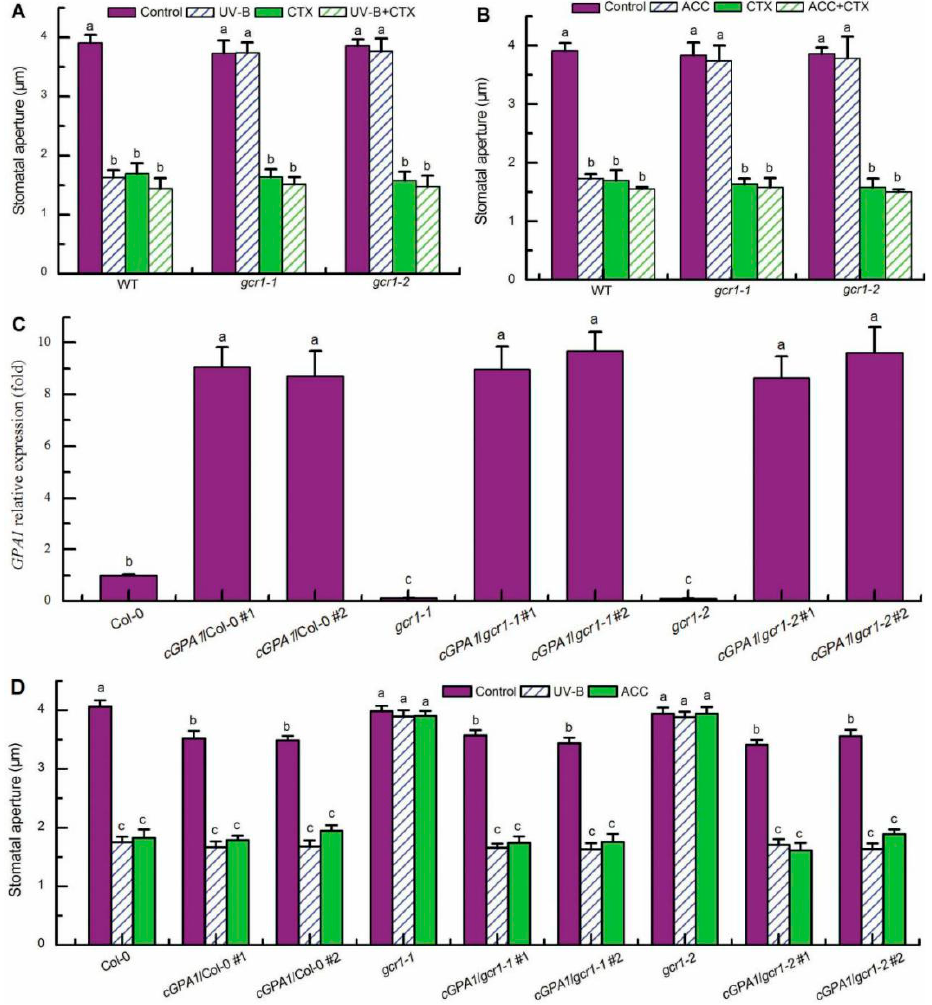
Figure 2. GCR1 mediates UV-B- and ethylene-induced stomatal closure via activating G α subunit GPA1. ( A ) Leaves of the wild-type Col-0 (WT) and gcr1 mutants with open stomata were floated on MES buffer under light alone (Control) or with 0.5 W/m 2 UV-B (UV-B) or the MES buffer containing 400 ng/mL CTX (CTX) for 3 h. ( B ) Leaves of the WT and gcr1 mutants with open stomata were incubated in MES buffer in the absence (Control) or presence of 100 μ mol/L ACC (ACC) or 400 ng/mL CTX (CTX) for 3 h under the light. ( C ) qPCR to assess GPA1 relative expression level in the leaves of T2 transgenic lines overexpressing cGPA1 in the background of wild-type Col-0 and the gcr1-1 and gcr1-2 mutants. The transcript level of GPA1 in Col-0 was set to one. Data are shown as means ± SE of three independent biological determinations, and means with different letters are significantly different at p < 0.01. ( D ) Leaves of the WT Col-0, gcr1 mutants, and transgenic lines cGPA1 /Col-0/ gcr1-1 / gcr1-2 with open stomata were floated on MES buffer under light alone (Con- trol) or with 0.5 W/m 2 UV-B (UV-B) or the MES buffer containing 100 μ mol/L ACC (ACC) for 3 h. For ( A ), ( B ), and ( D ), stomatal apertures were measured in epidermal strips taken from the abaxial surfaces of the treated leaves. Data are shown as means ± SE ( n = 3), each with 30 stomata. Means with different letters are significantly different at p < 0.01.